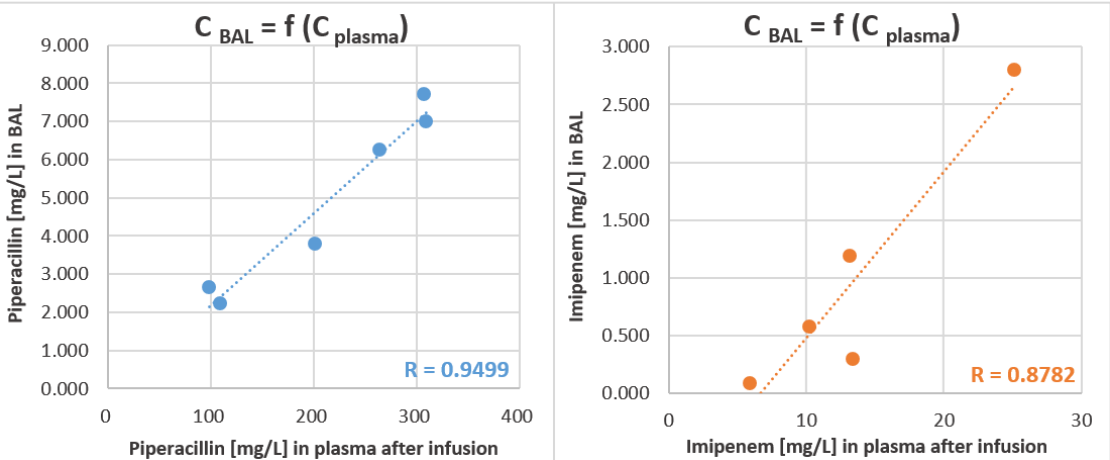
Figure 6. Concentrations [mg/L] of piperacillin (blue, left panel) and imipenem (orange, right panel) in BAL samples in the function of antibiotic level in plasma [mg/L]. Both sample types were collected at the same time, i.e., one hour after the end of intravenous infusion. Tentative linear regression is given as a dotted line along with the corresponding value of the Pearson Correlation Coefficient.